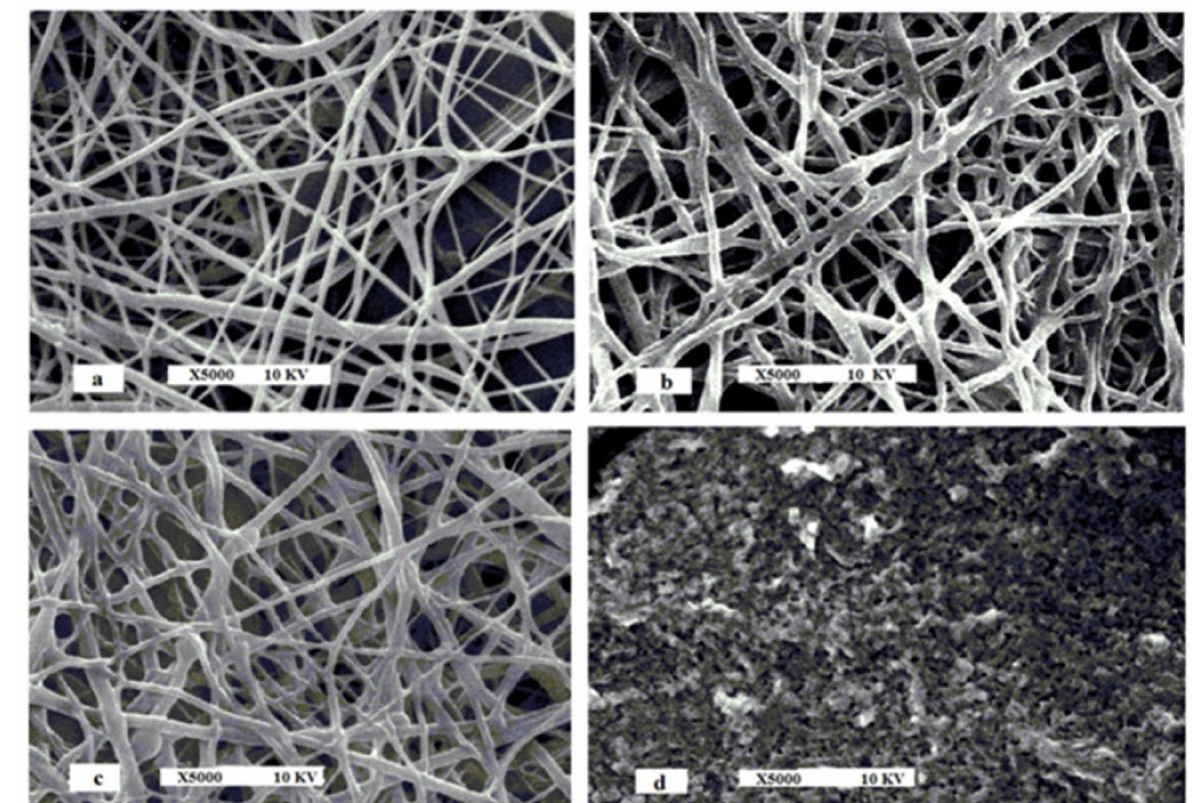
Figure 9. SEM Micrographs of ( a ) electrospun CS-PVA NFM, ( b ) activated electrospun CS-PVA NFM, ( c ) AChE/electrospun CS -PVA NFM, ( d ) AChE/CS-PVA CM (casted electrode). Published from [186] with the permission of the